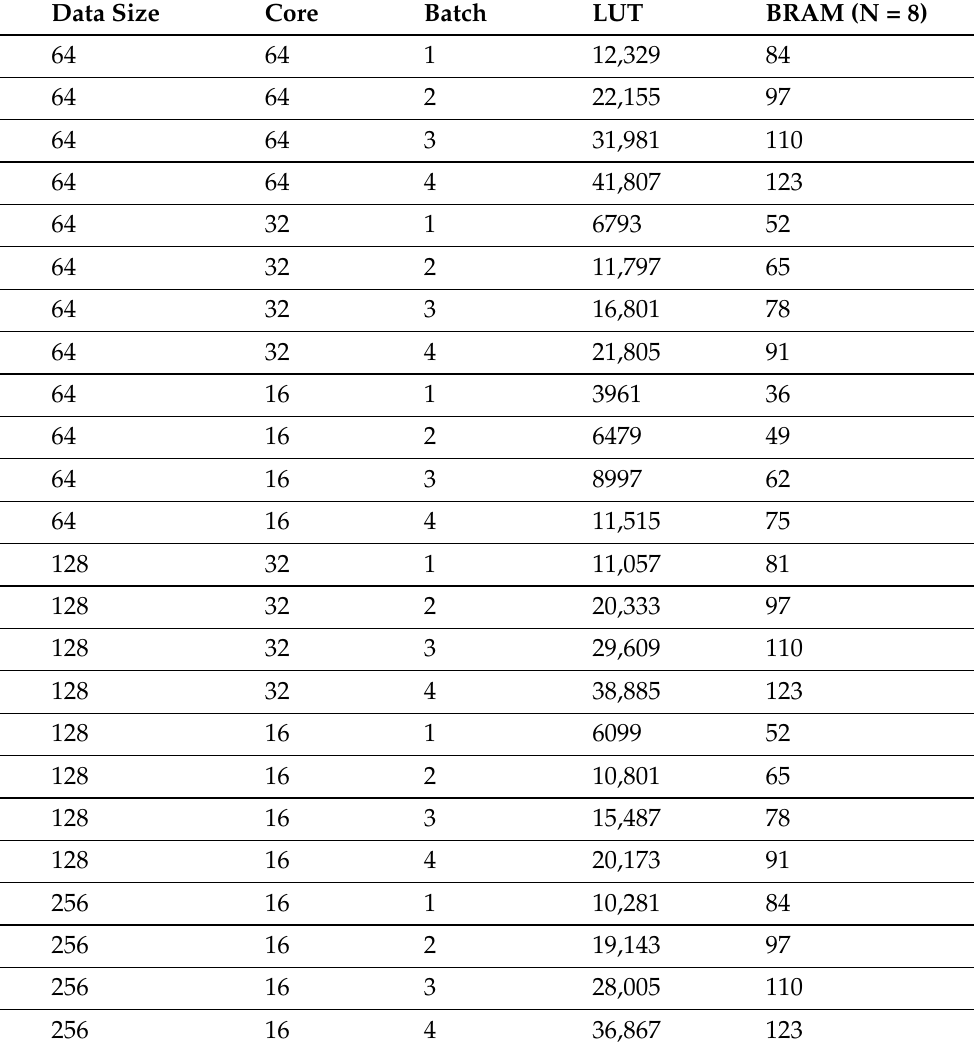
Table 2. Resource utilization for different configurations of the